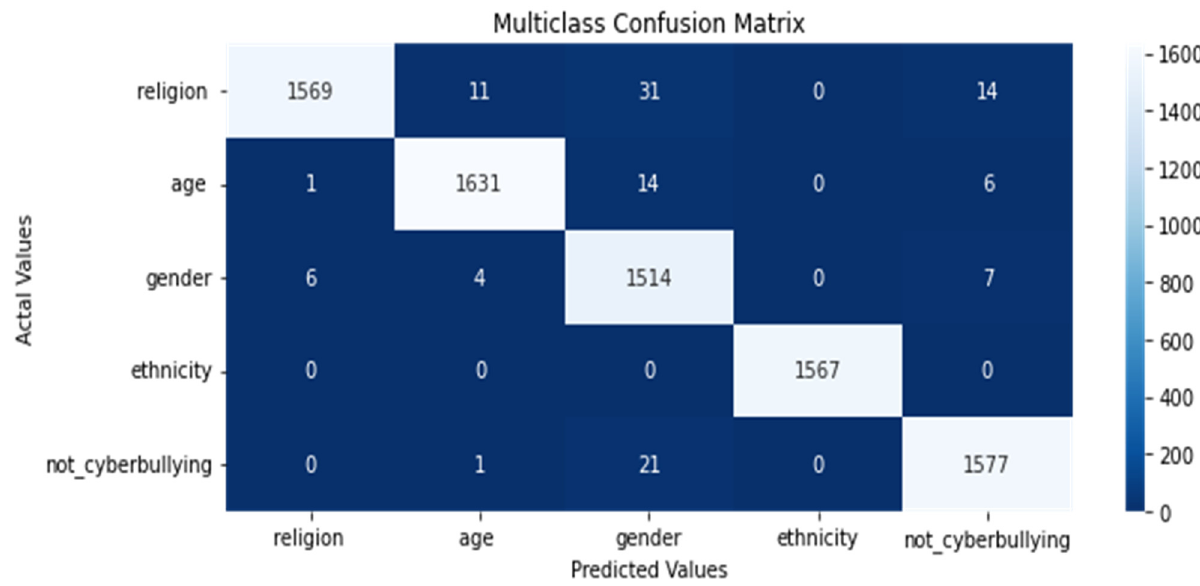
Figure 9. Confusion matrix of the BiLSTM model using the multiclass classification dataset.